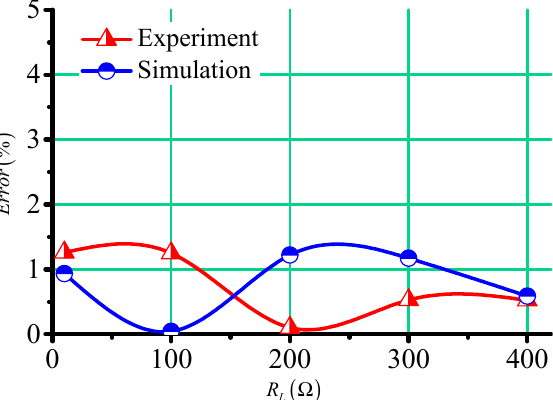
Figure 12. The temperature error in the simulations and experiments.